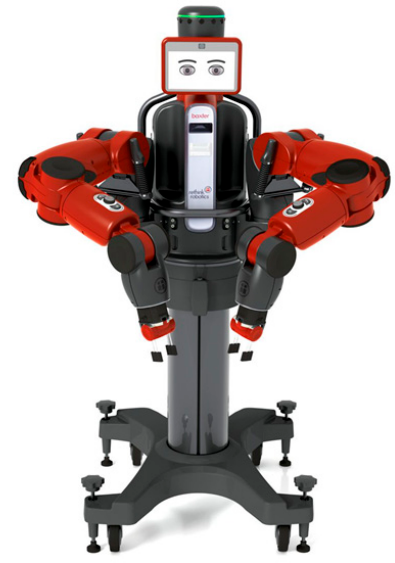
Figure 1. Baxter Robot.